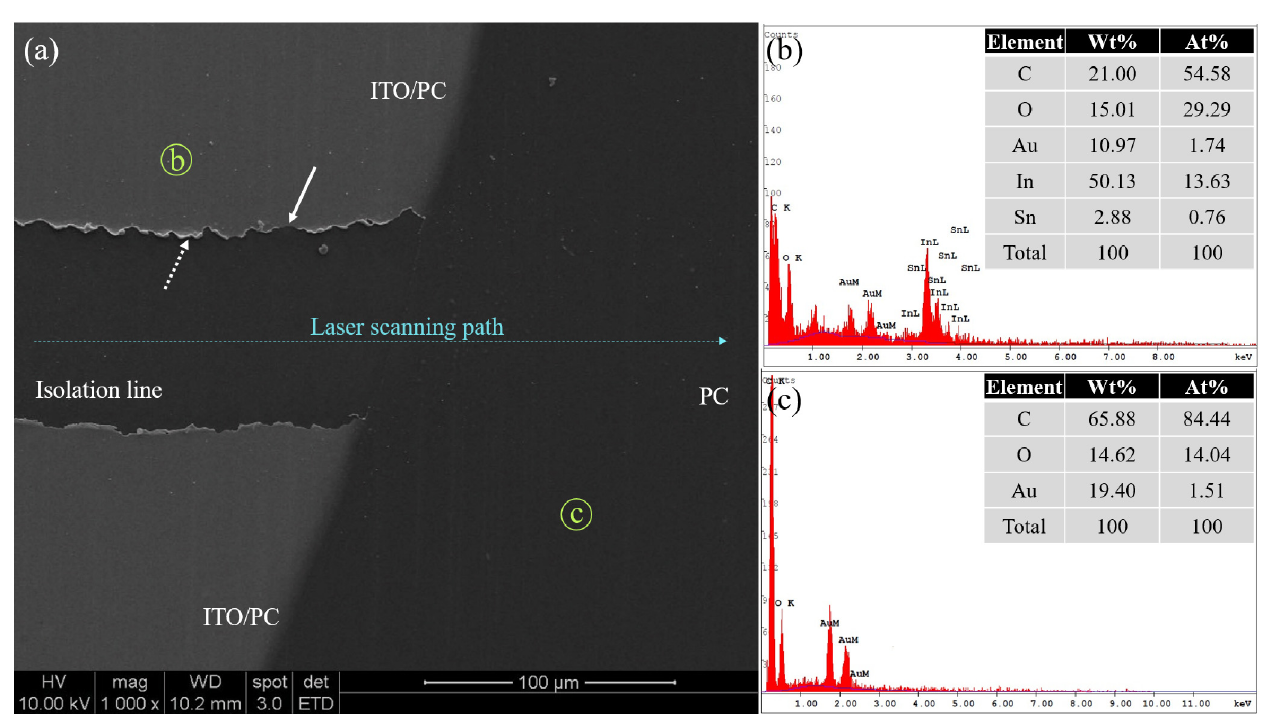
Figure 1. ( a ) Surface morphology of the ITO/PC and PC was treated by laser. ( b ) is EDS spectrum of site b in ( a ). ( c ) is EDS spectrum of site c in ( a ).